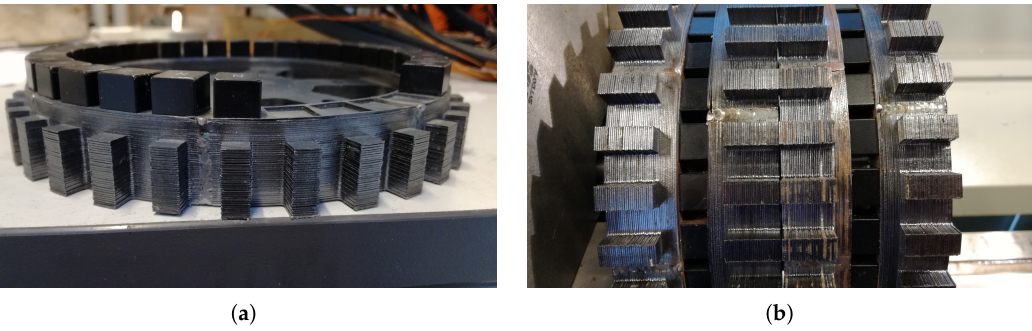
Figure 18. Assembly of the rotor ( a ) PM assembly, and ( b ) complete assembly.